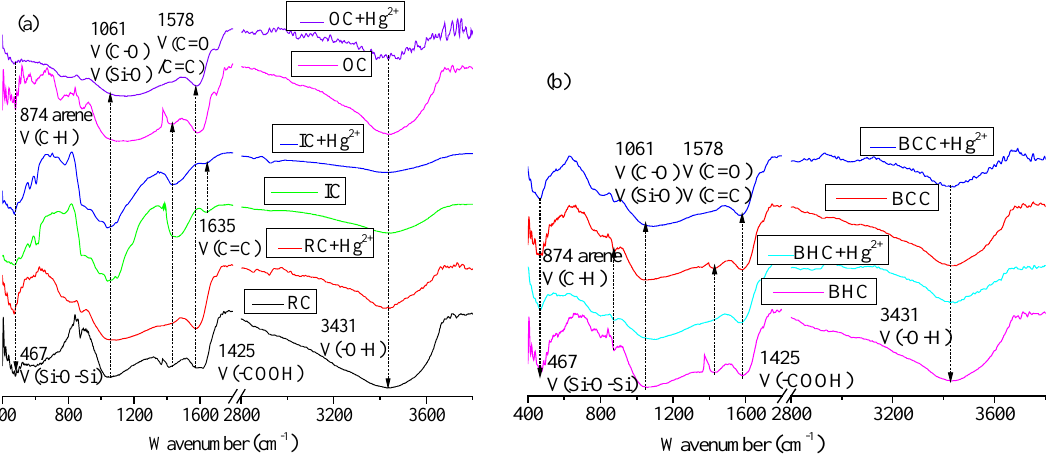
Figure 1. FTIR spectra before and after Hg 2 + adsorption by biochar ( a ): RC, IC, and OC; ( b ): BHC and BCC.